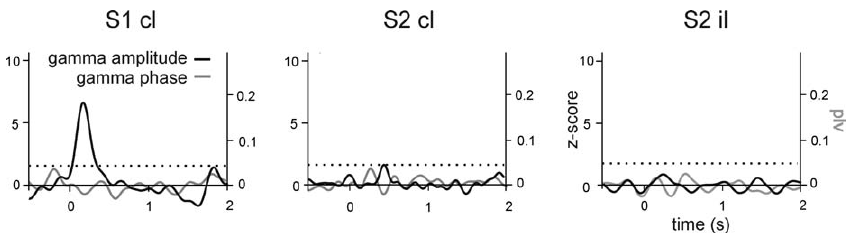
Figure 2. Gamma Amplitude and Gamma Phase Locking in Somatosensory Cortices Gamma amplitude (black line) and gamma phase locking (plv, gray line) are shown for the contralateral primary somatosensory cortex (S1 cl) and the bilateral secondary somatosensory cortices (S2 cl and S2 il). The left and right axes and labels correspond to amplitude and phase, respectively. Amplitudes are given in z -scores, and phase is given as phase-locking value (plv; see Methods). The dotted line represents the confidence level as determined from permutation statistics. The increase of gamma oscillations (black line) without a significant change of phase locking (gray line) confirms that gamma oscillations are induced and not evoked.